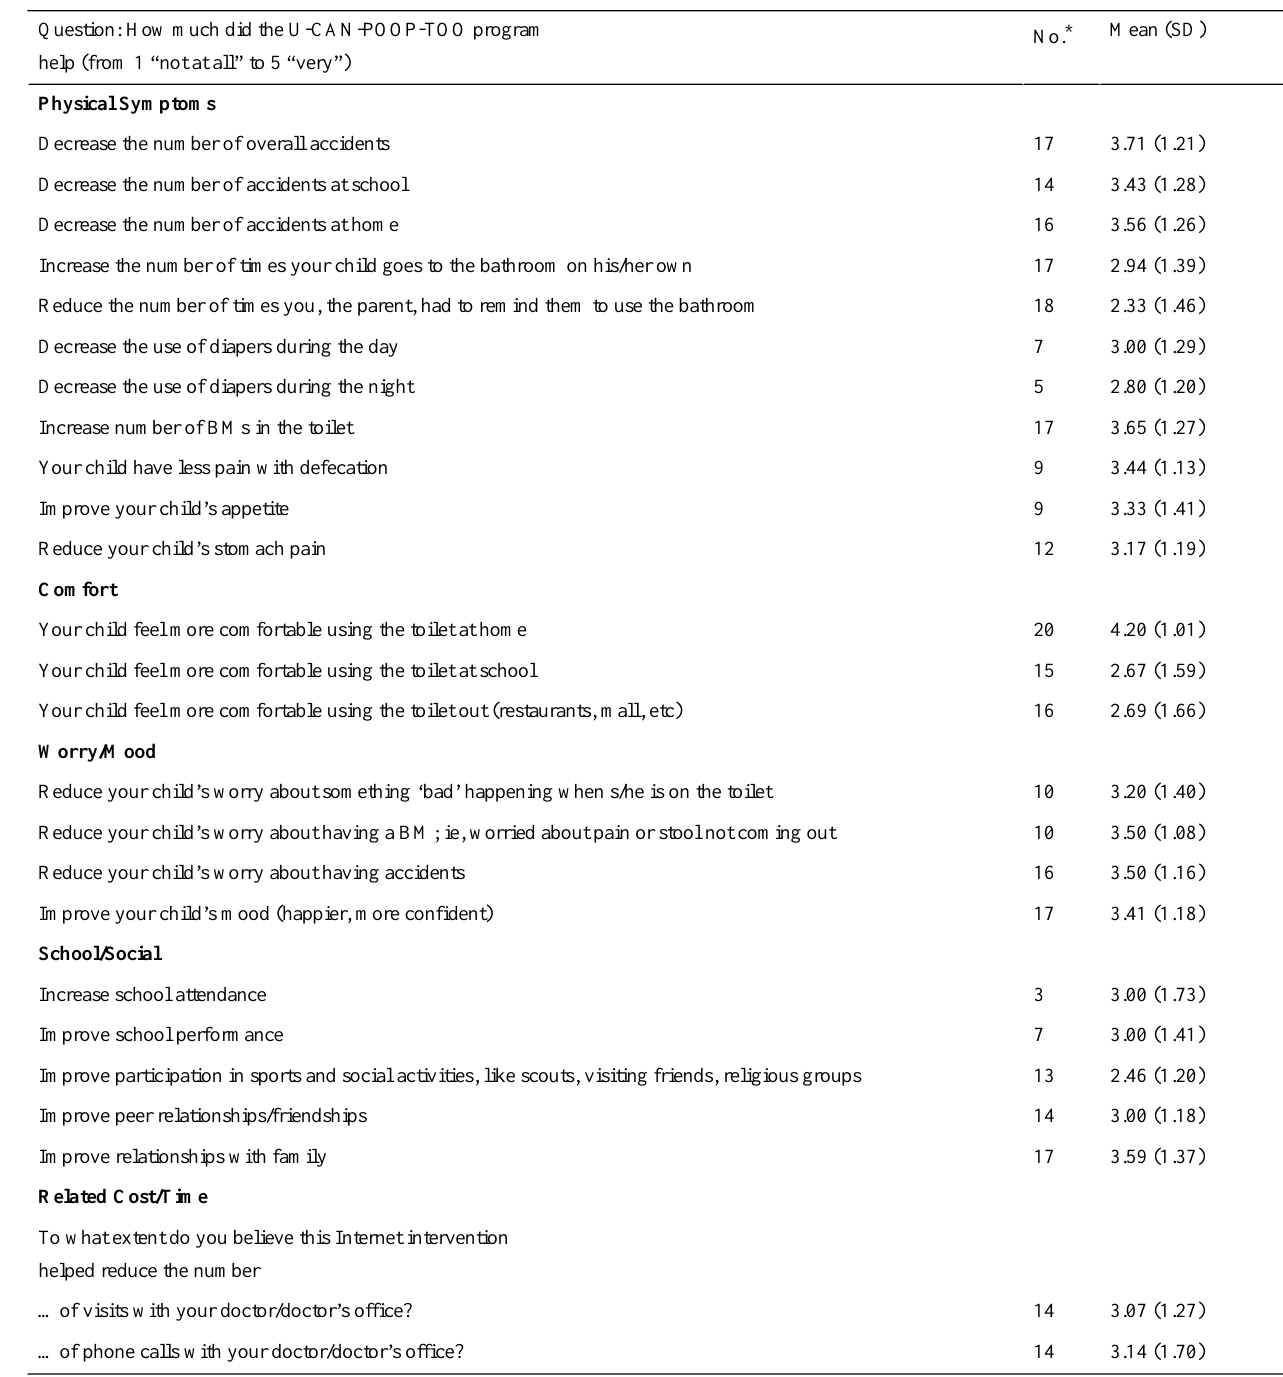
Table 3. U-CAN-POOP-TOO Impact Questionnaire